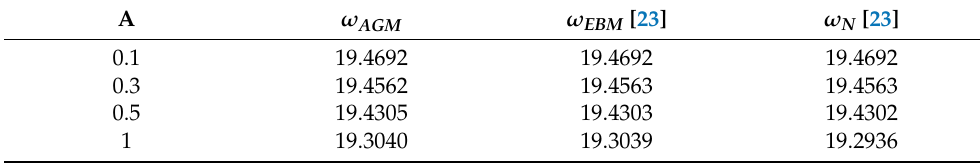
Table 4. Comparison between AGM, EBM and exact numerical solution (C-C